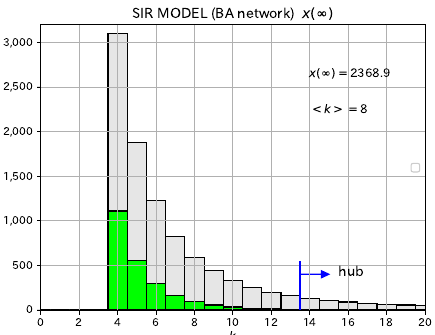
Figure 11. The distribution of degrees of the final noninfected individuals x ( ∞ ) for the BA network in green color. The distribution of the total nodes is given in gray.